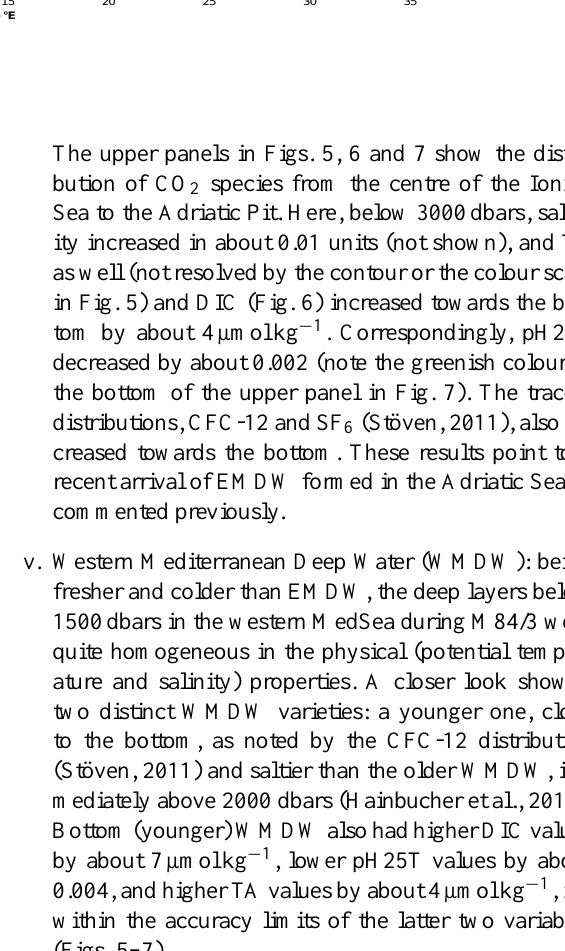
Fig. 7. As in Fig. 5 but for pH25T.